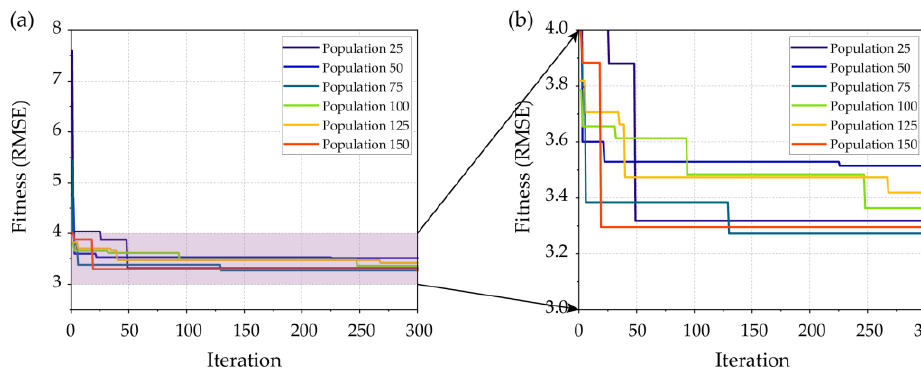
Figure 3. CMRSA–ANN model development: (a) iteration curves; (b) local comparison.